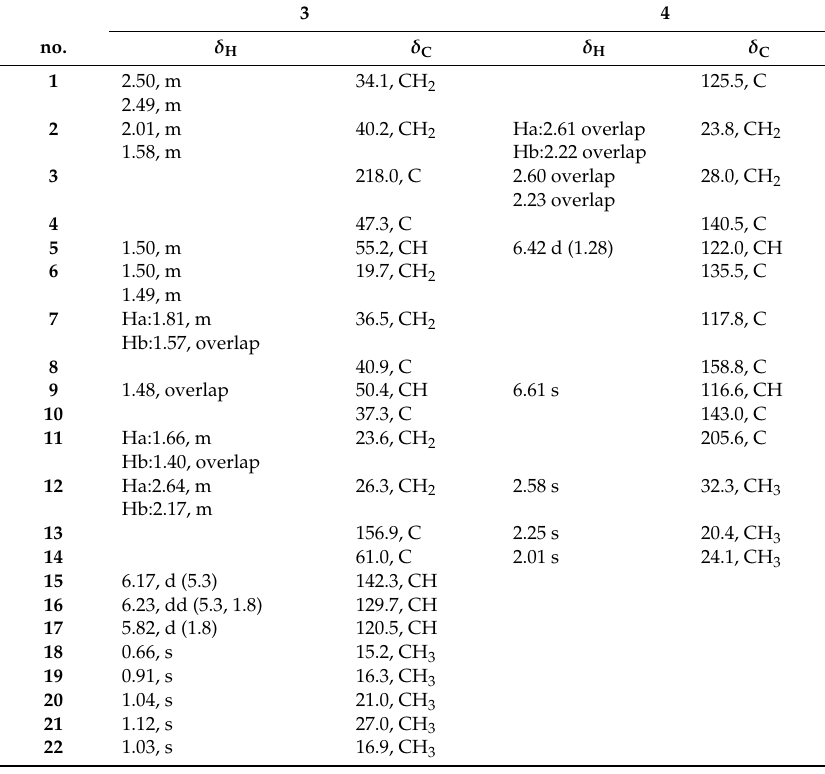
Table 2. 1 H (800 MHz) and 13 C NMR (200 MHz) Data of 3 and 4 in CDCl 3 ( δ in ppm, J in Hz).